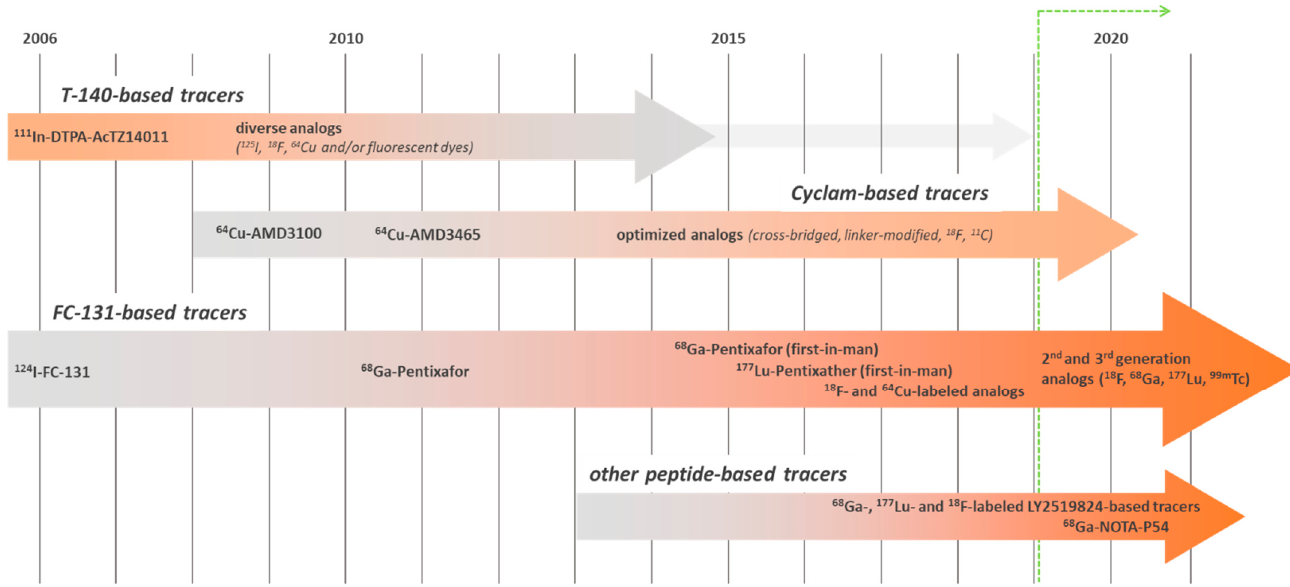
Figure 2. Historical evolution and relevance of the development of CXCR4-targeted imaging probes based on different chemical scaffolds (green line indicates the timeframe covered in this review).